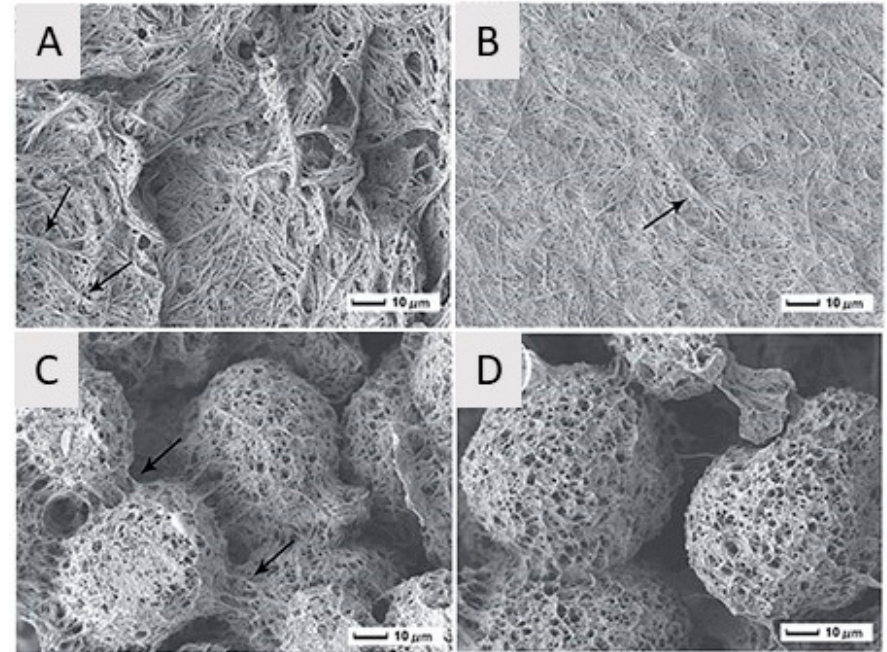
Figure 5. SEM images of PLLA nanofibers and microspheres obtained from PLLA/dimethylformamide (DMF) solutions as a function of PLLA concentration: ( A ) 1 w/v %, ( B ) 3 w/v %, ( C ) 5 w/v % and ( D ) 7 w/v % (quenching time: 10 min; crystallization temperature: − 10 °C; scale bar: 10 µm)—reproduced with permission from [65], Copyright Royal Sociaty of chemistry, 2015.